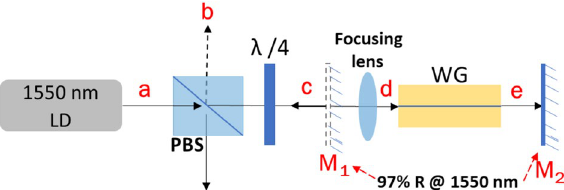
Figure 2. Experimental configuration to measure CL and TL (and thus PL) through a WG. A 1550 nm LD is used as the probe beam. λ/4 is the quarter waveplate, PBS is the polarized beam splitter. M 1 and M 2 are the 97% reflecting mirror @ 1550 nm, placed at point ‘ c ’ and ‘ e ’ without and with sample respectively. Probe beam loss in the forward beam path (‘ a ’ to ‘ e ’) is measured at point ‘ e ’ (details in supplement 1) and the beam loss in the reflecting path (from ‘ e ’ to ‘ b ’) is measured at point ‘ b